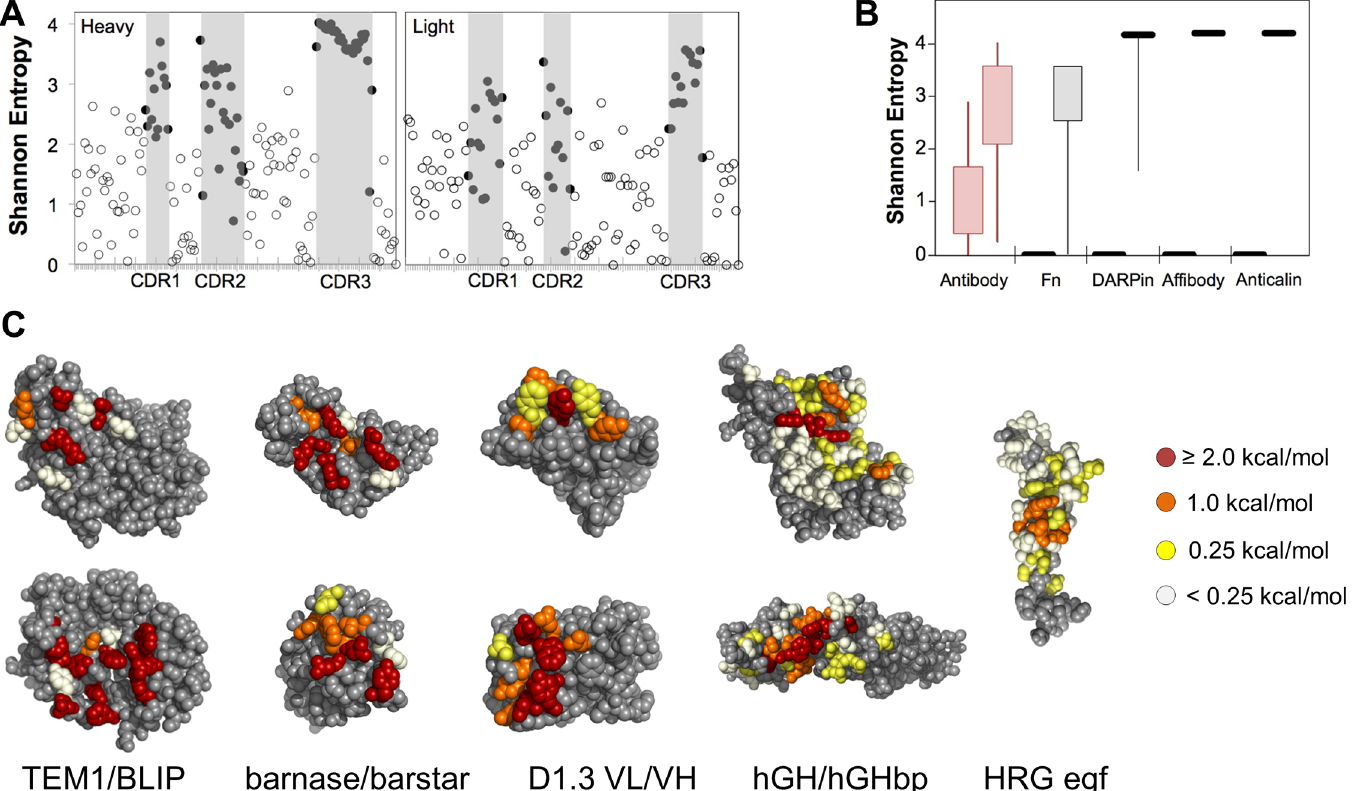
Fig 1. Diversity gradients in binding molecules. (A) The amino acid diversity, measured as Shannon entropy of antibody sequences (from the abysis database at http://www.bioinf.org.uk/abysis/) in the framework (open circles, white background) and CDRs (solid circles, gray background). (B) The Shannon entropy of combinatorial library designs for antibody (data from A ), fibronectin (Fn) [40], designed ankyrin repeat (DARPin) [41], affibody [42], and anticalin [43], domains. (C) The relative impact of alanine mutation on binding is shown for several protein interfaces: TEM1- β – lactamase (TEM1) and β -lactamase inhibitor protein (BLIP) (PDB: 1JTG) [44]; extracellular RNase (barnase) and its intracellular inhibitory binding partner (barstar) (PDB: 1BRS) [45]; light and heavy chain variable regions of anti-hen egg white lysozyme antibody D1.3 in the context of binding anti-D1.3 antibody E5.2 (not shown) (PDB: 1DVF) [46]; human growth hormone (hGH) and extracellular domain binding partner (hGHpb) (PDB: 1A22) [47,48]; heregulin β (HRG) egf domain in the context of binding ErbB3 receptor-IgG fusion (not shown) (PDB: 1HAE) [49].